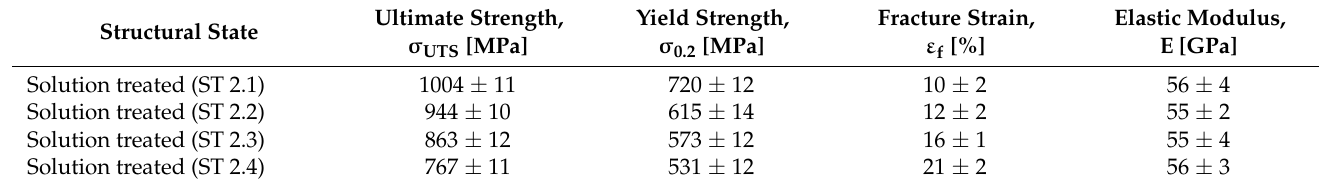
Table 6. Mechanical characteristics of TNTZ alloy solution treated at 900 ◦ C with holding times of: